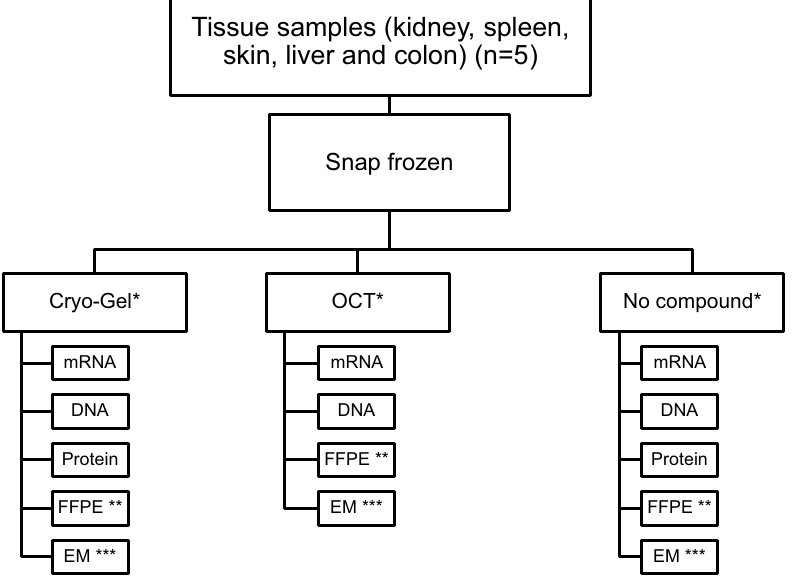
Figure 1. Flowchart showing the work-up protocol performed on normal tissue samples from kidney, spleen, skin, colon and liver. Samples were embedded in either Cryo-Gel, OCT or without compound. * Two samples were embedded from the different tissues for each embedding medium. For the renal tissues, the additional performed techniques were all performed in duplicate. ** H&E was performed on all tissue samples. PAS, Jones, Trichrome and immunohistochemistry for AE1/AE3 and CD31 were performed in the renal samples. PAS, trichrome, Sirius Red and Iron stain were performed in the liver samples. *** EM was only performed on the renal